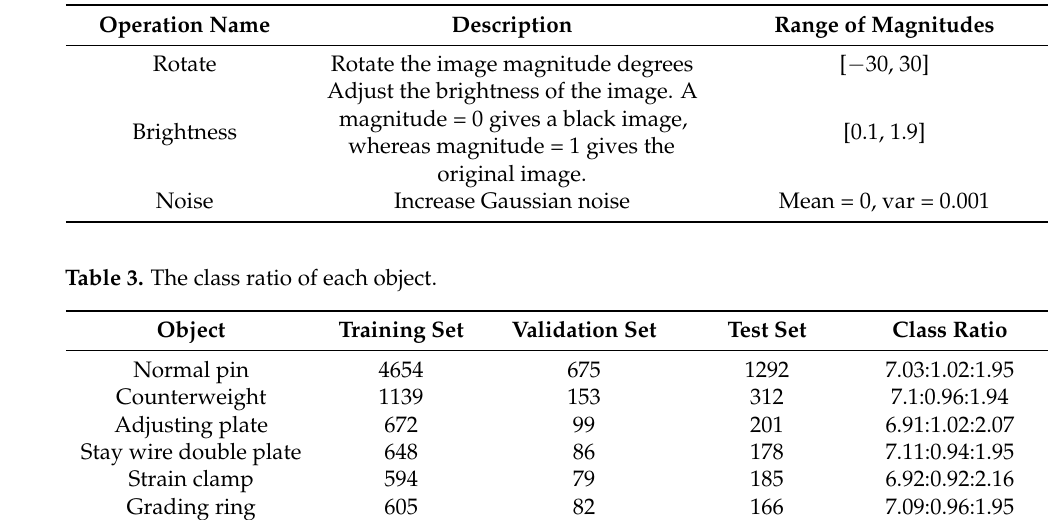
Table 2. The preprocessing parameters of the data augmentation.